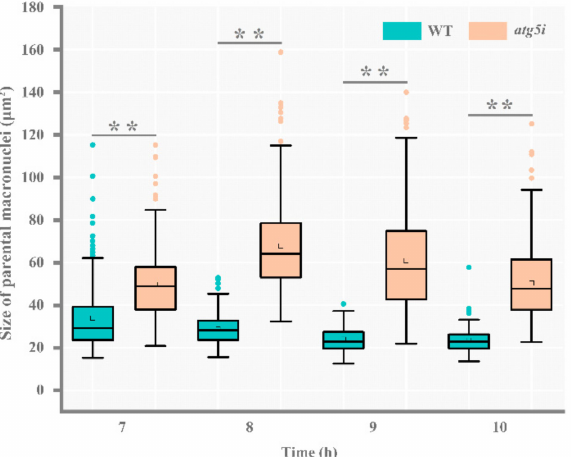
Figure 6. Condensation of paMAC was prevented after RNA interference of ATG5 . Comparison of parental macronuclear size of mating WT cells and mating atg5i mutant cells at 7, 8, 9, and 10 h. Box plot explanation: upper horizontal line of box, 75th percentile; lower horizontal line of box, 25th percentile; horizontal bar within box, median; upper horizontal bar outside box, 90th percentile; lower horizontal bar outside box, 10th percentile. The green and orange circles represent the outliers of WT cells and atg5i mutant cells, respectively. n = 100 (cell number of pair cells). An unpaired sample t test was used for statistical analysis. ** p <